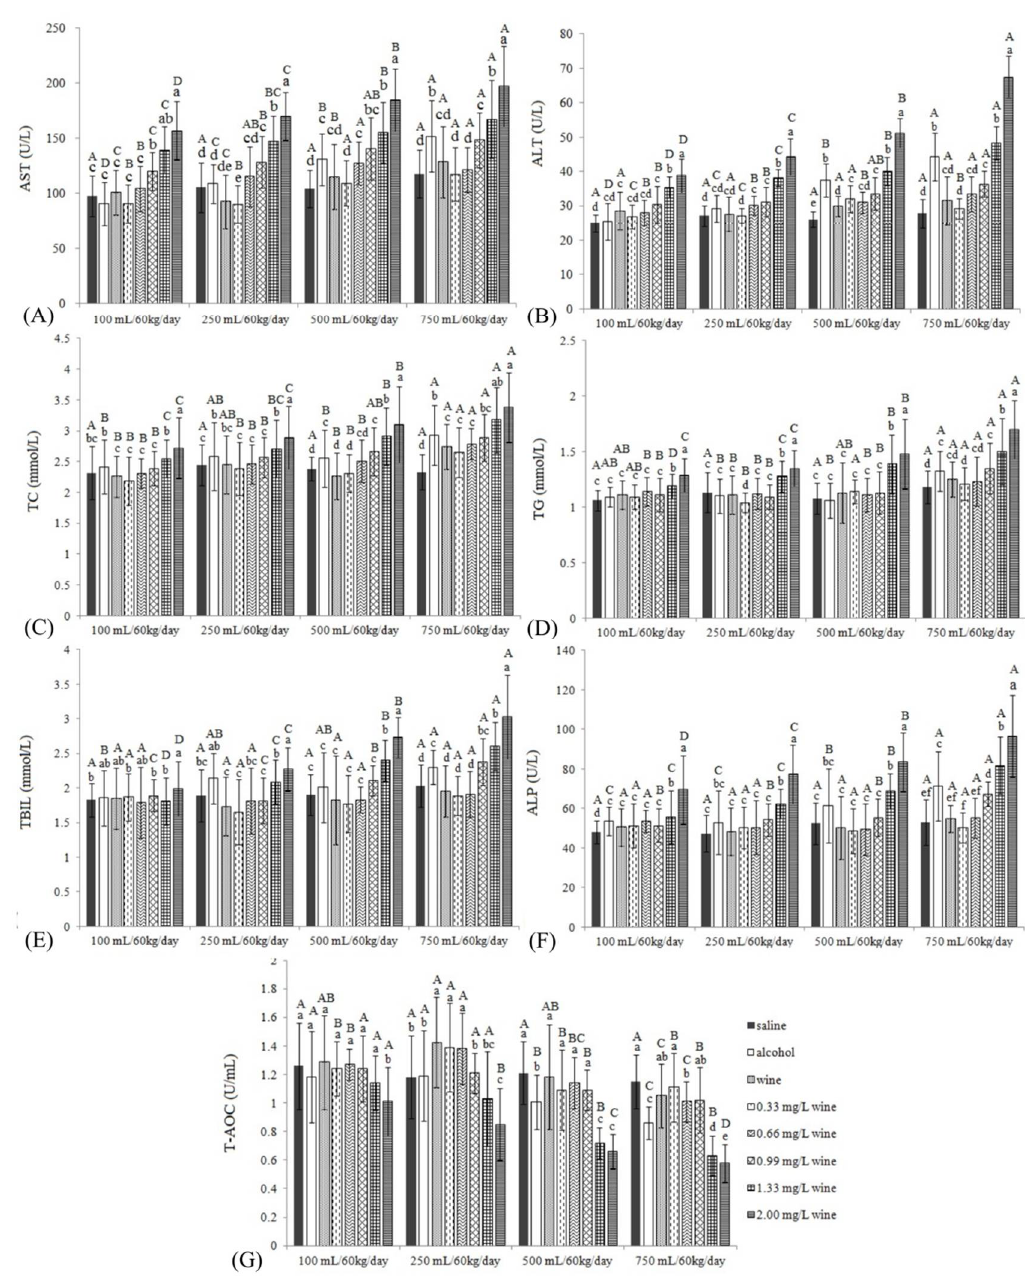
Figure 1. The AST ( A ), ALT ( B ), TC ( C ), TG, ( D ) TBIL ( E ), ALP ( F ), and T-AOC ( G ) levels in the serum of mice. Different capital letters indicate significant differences between treatment groups, and different lowercase letters indicate significant differences within the same dose groups ( p < 0.05).